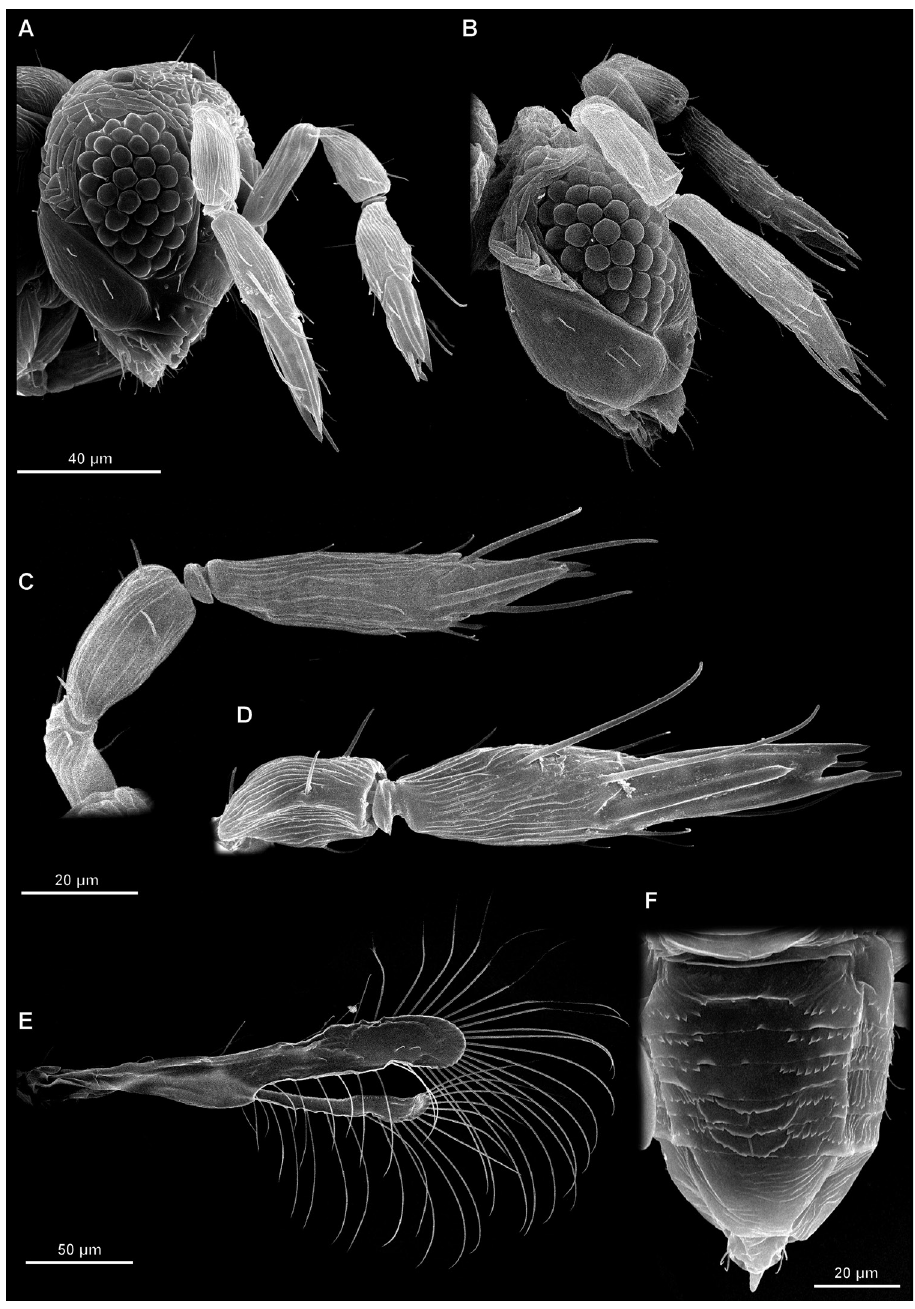
Figure 2. Diagnostic characters of Megaphragma caribea , SEM: A head of female B head of male C antennal club, male D antennal club, female E wings F terga of